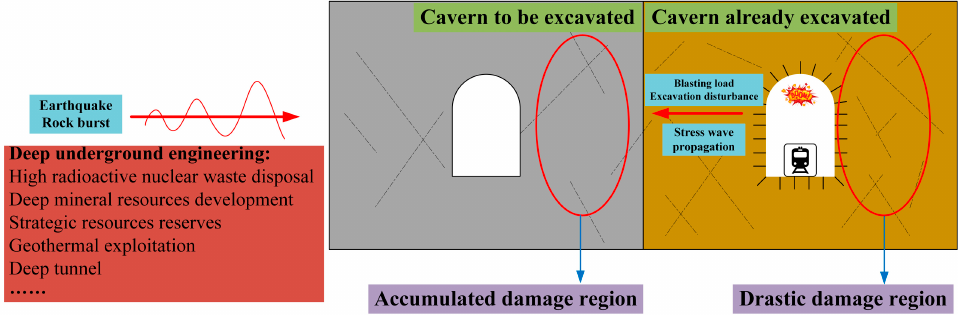
Figure 1. Overview of rock dynamics and accumulated damage problems in deep underground engineering.